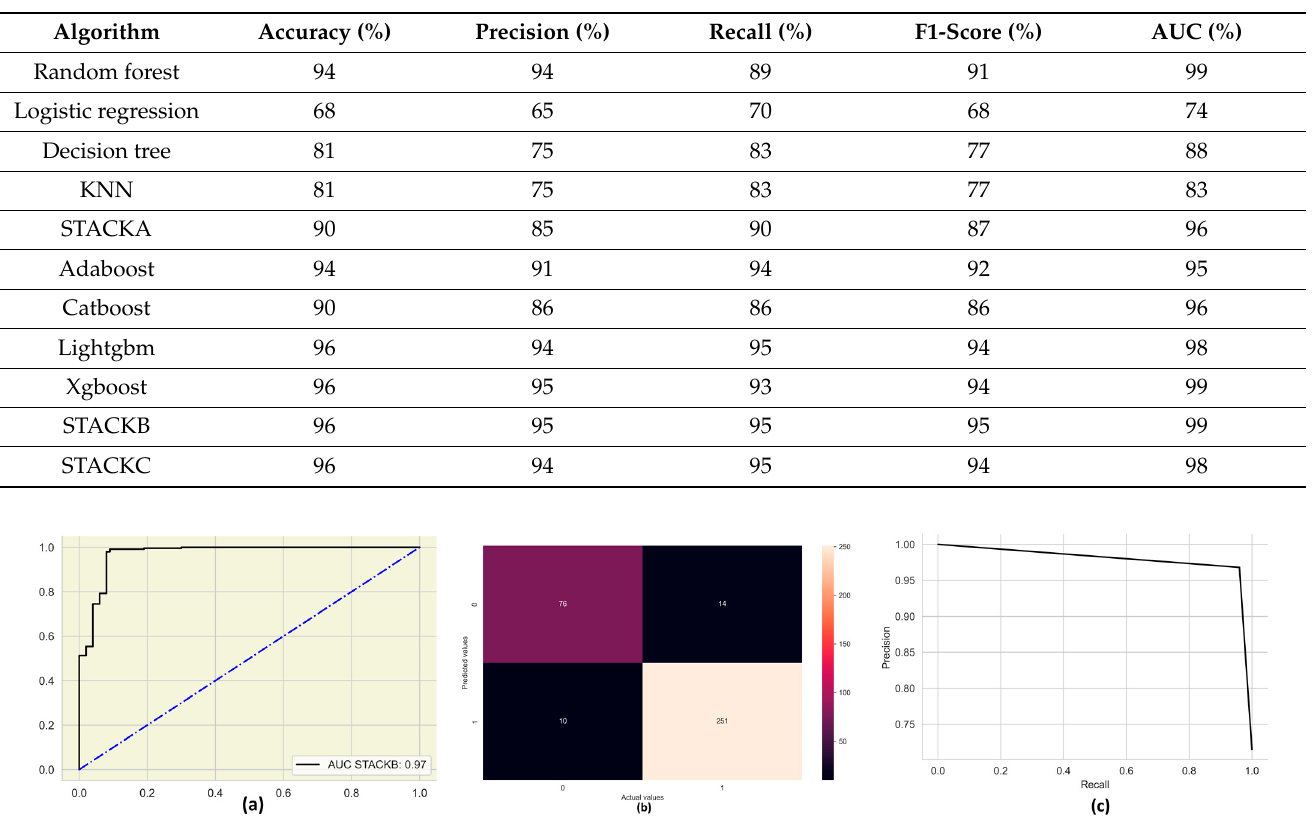
Table 3. Results obtained by ML classifiers.